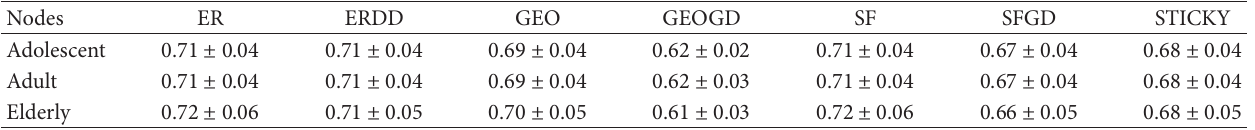
Table 2: Average GDD agreement in different groups.